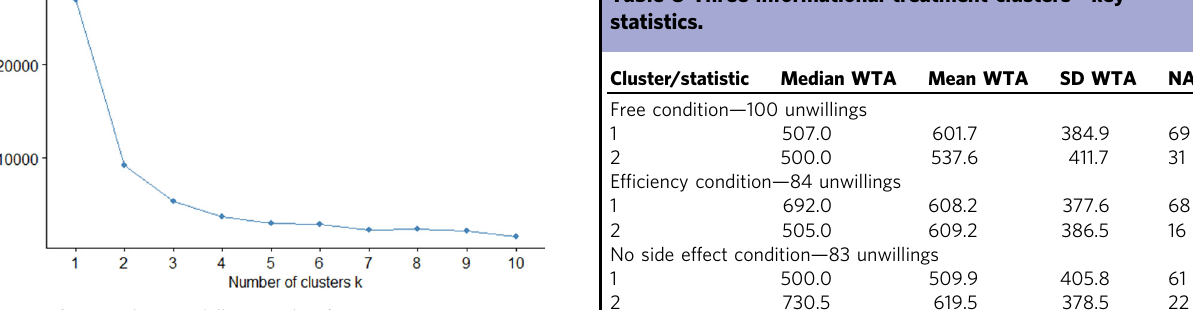
Table 8 Three informational treatment clusters —